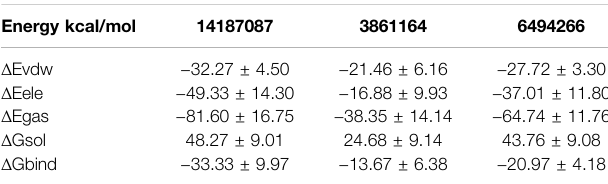
TABLE 2 | Binding free energy calculations of all three complexes. Δ Egas, molecular mechanics energy in the gas phase; Δ Eele, electrostatic energy; Δ Evdw, van der Waals potential energy; Δ Gsol, solvation free energy; Δ Gbind, binding energy. Energy